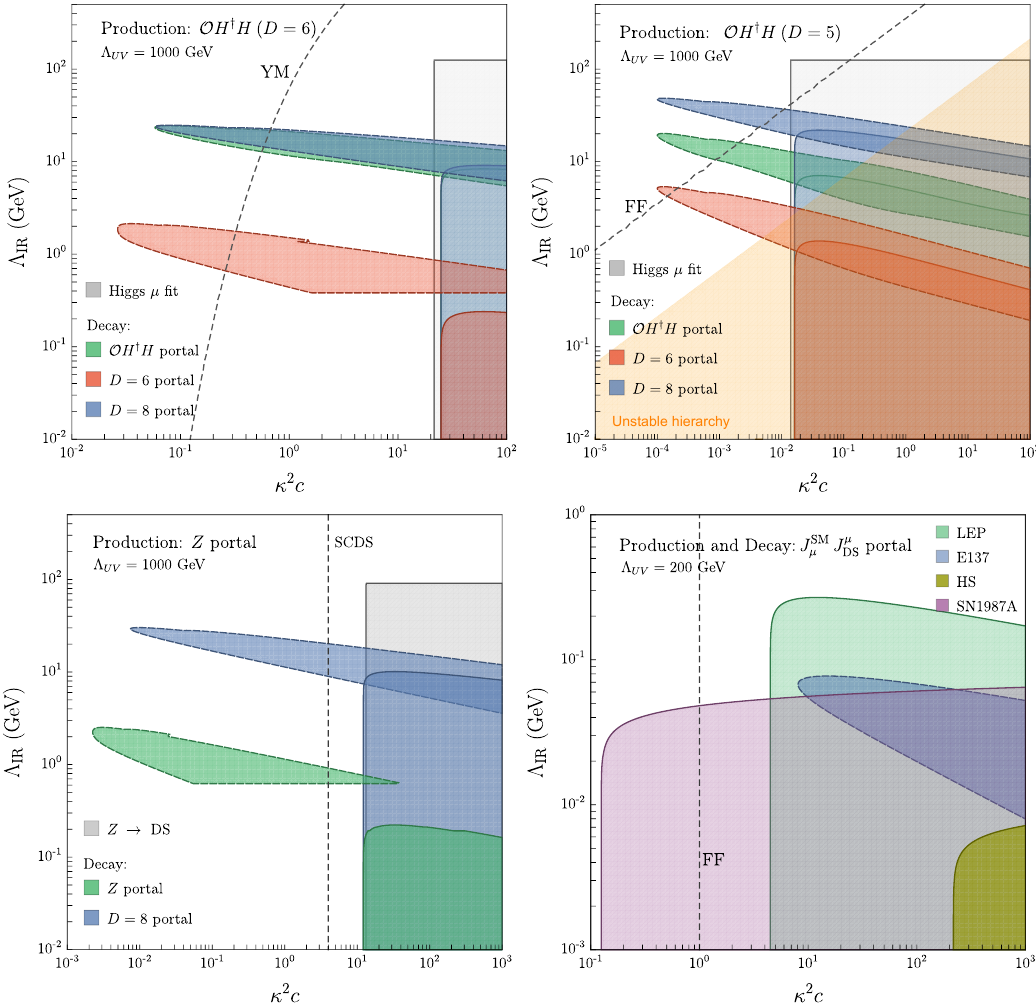
Figure 15 . Exclusions at 95% probability in the plane ( κ 2 c, Λ IR ) for fixed Λ UV and various portals. Continuous contours in the upper two panels show the exclusions from the fit to Higgs couplings and the bound on the Higgs invisible branching ratio, while those in the lower left panel arise from the invisible Z decay width and mono-jet searches at the LHC. Dashed contours in these same panels show exclusions from displaced decays at the LHC. The lower right panel shows exclusions from LEP mono-photon searches, E137, SN1987A and stellar evolution (note that the SM current is different for each of these, so they probe different portals. We are taking the simplifying limit of κ being the same for all of them). Bounds from other experiments analyzed in the text are too weak to appear in the plots. The dashed curves show the predictions of the benchmark models of section 2 for the following values of the parameters: y = 1 , y = 0 , N = 3 for the pure L R DC Yang-Mills model of section 2.1 (YM) and the strongly-coupled DS model of section 2.2 (SCDS); λ HS = 1 and y = 1 for the free fermion models of section 2.3